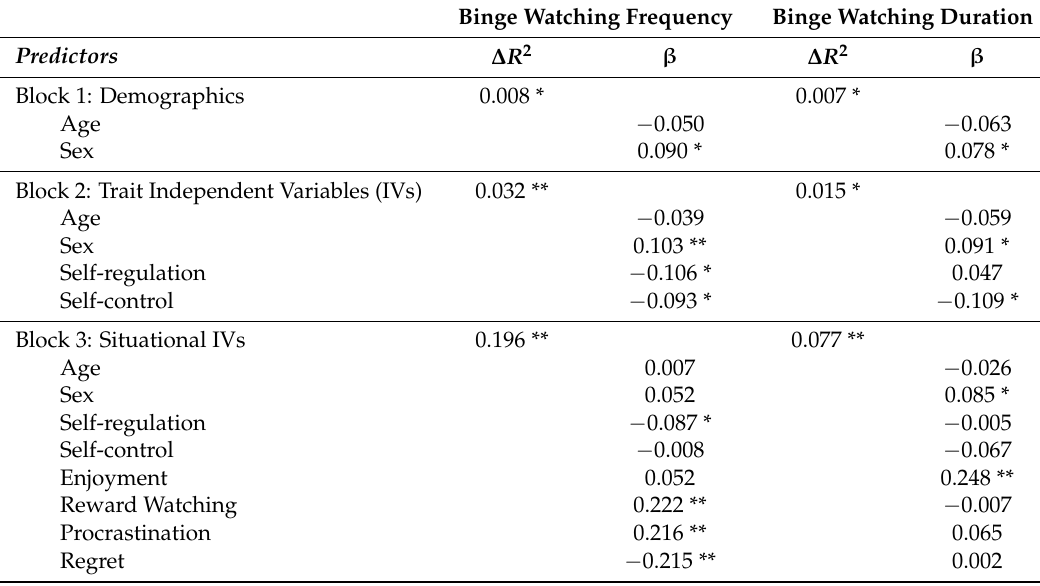
Table 1. Summary of variables predicting binge watching frequency and duration ( N =